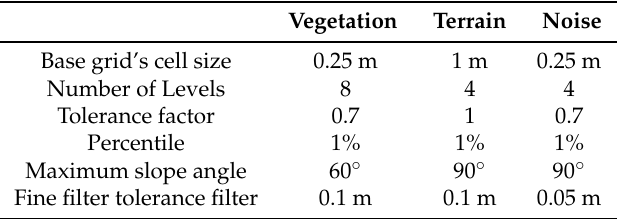
Table A1. Settings for the off-terrain point